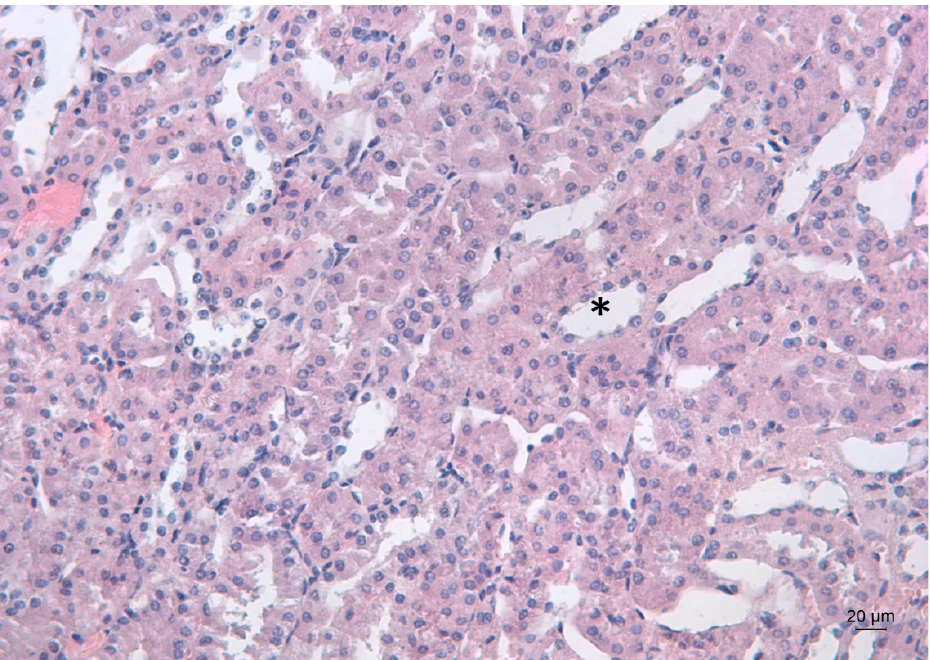
Figure 5. Representative photomicrograph of a kidney section of a Pb-exposed mouse, treated with deferiprone. Subsequent deferiprone administration resulted in some renal tubule dilation (*), which is often associated with degeneration. HE staining, ×200.